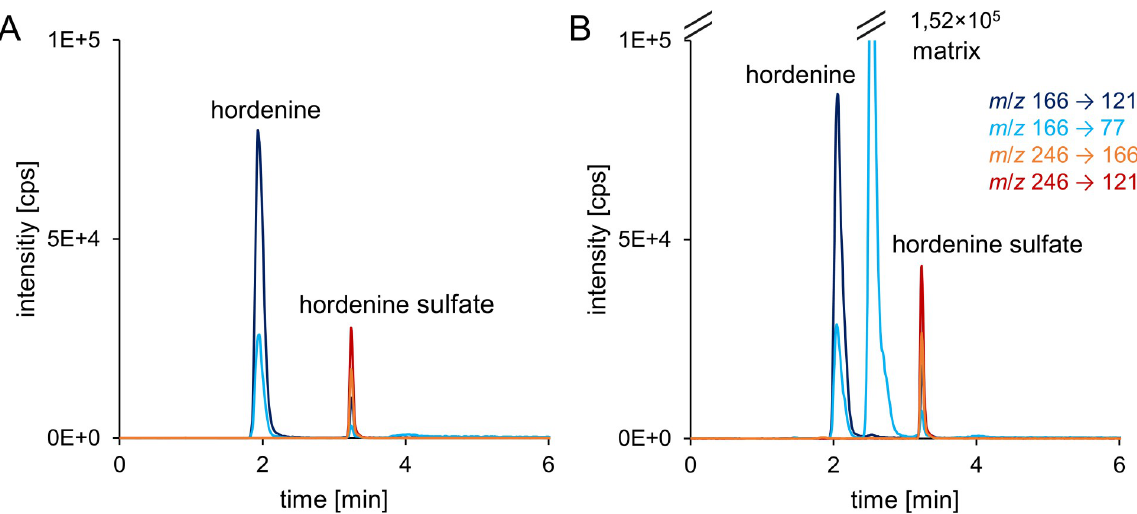
Fig 2. Extracted ion chromatograms of standard solution containing 500 nM hordenine and hordenine sulfate diluted in MeOH/H 2 O (1+19, v / v ) (A) and in cell culture matrix (B). Both qualifier and quantifier MRM transitions are shown. The matrix signal (intensity: 1,52 × 10 5 cps) is resulting from cell culture